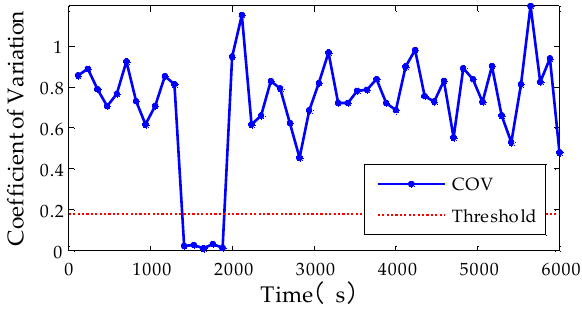
Figure 6. Time history of acceleration response at m 2 .